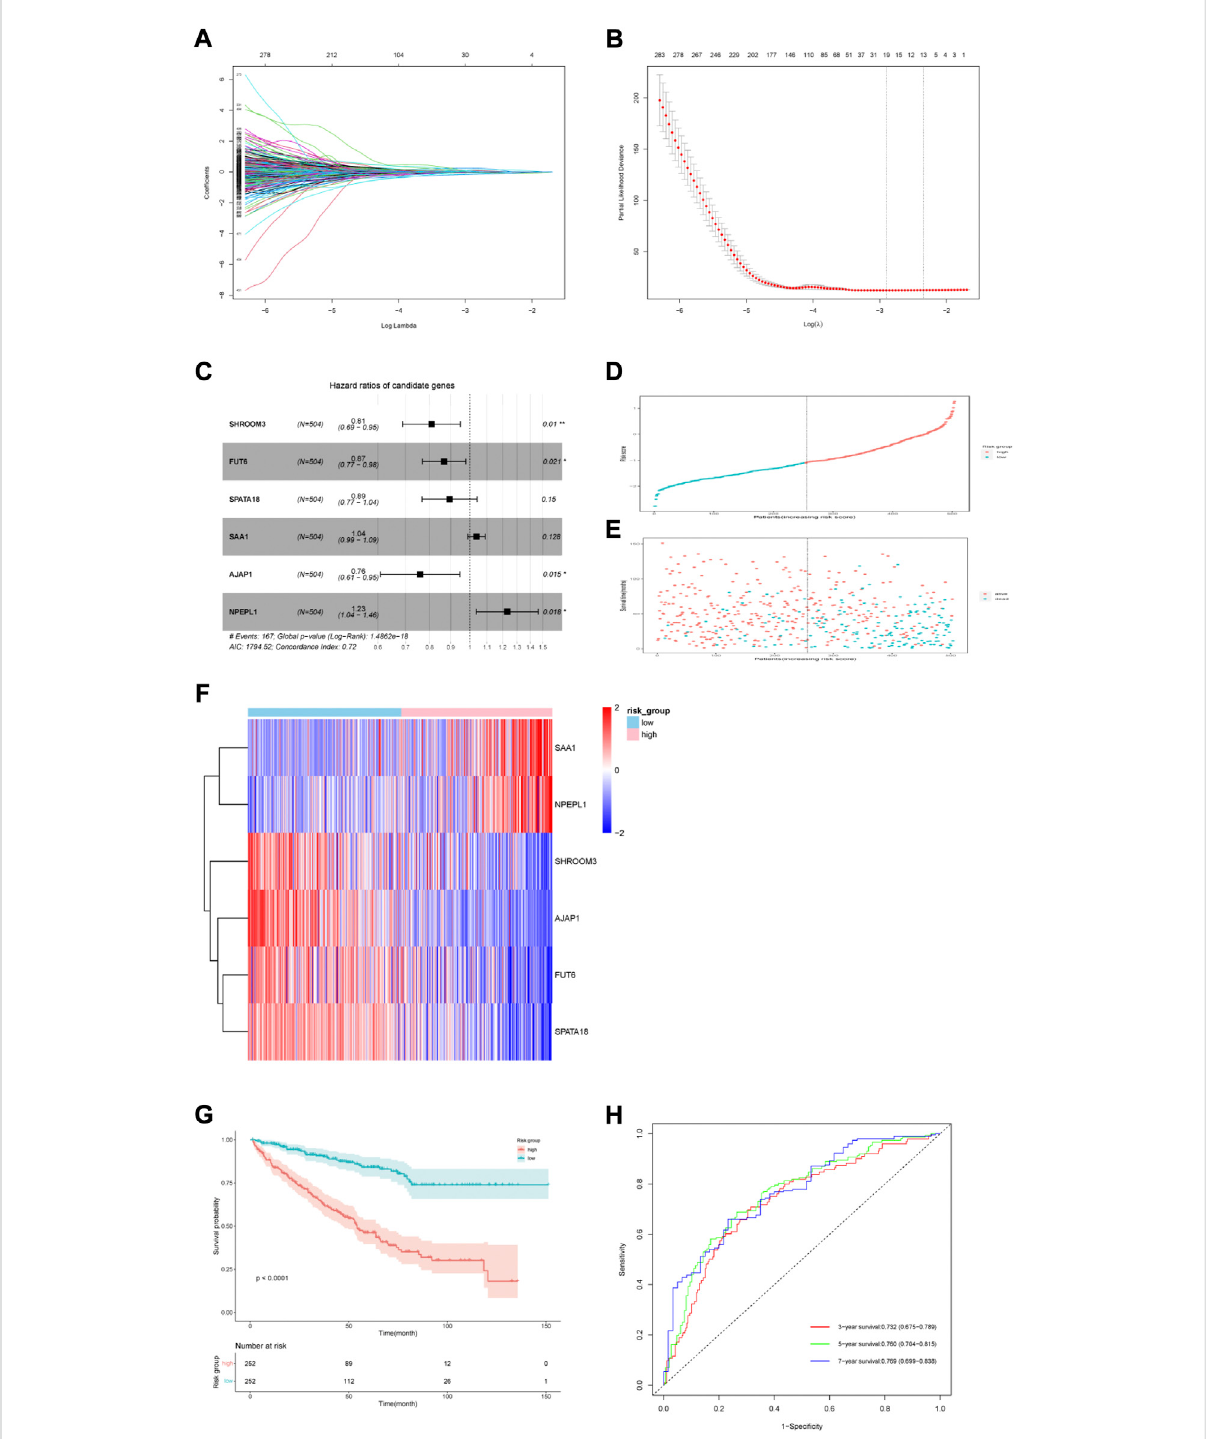
FIGURE 4 Six-gene risk score model construction in the TCGA cohort. (A) LASSO coef fi cients. (B) 10-time cross validation for tuning parameter selection by LASSO regression. (C) Multivariable Cox proportional hazard model of six genes. (D) Risk score distribution of high-risk and low-risk patients. (E) Survival status scatter plots for high-risk and low-risk patients. (F) Heatmap of nine genes in the two risk groups. (G) Kaplan – Meier (KM) estimate of the overall survival (OS) in the two risk groups. (H) The time-dependent ROC curves for 3-, 5- and 7-year survival